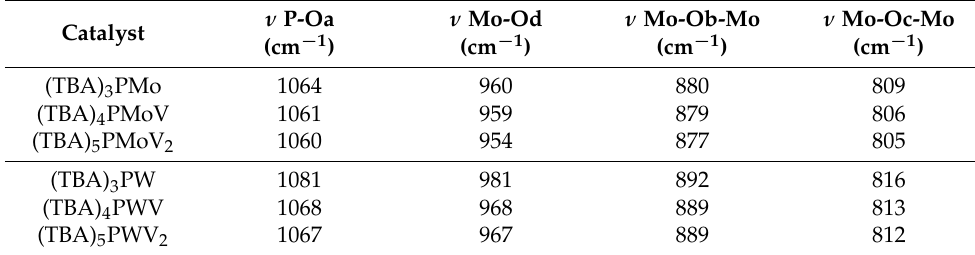
Table A3. Characteristic FT-IR bands of the pure and substituted Mo and W